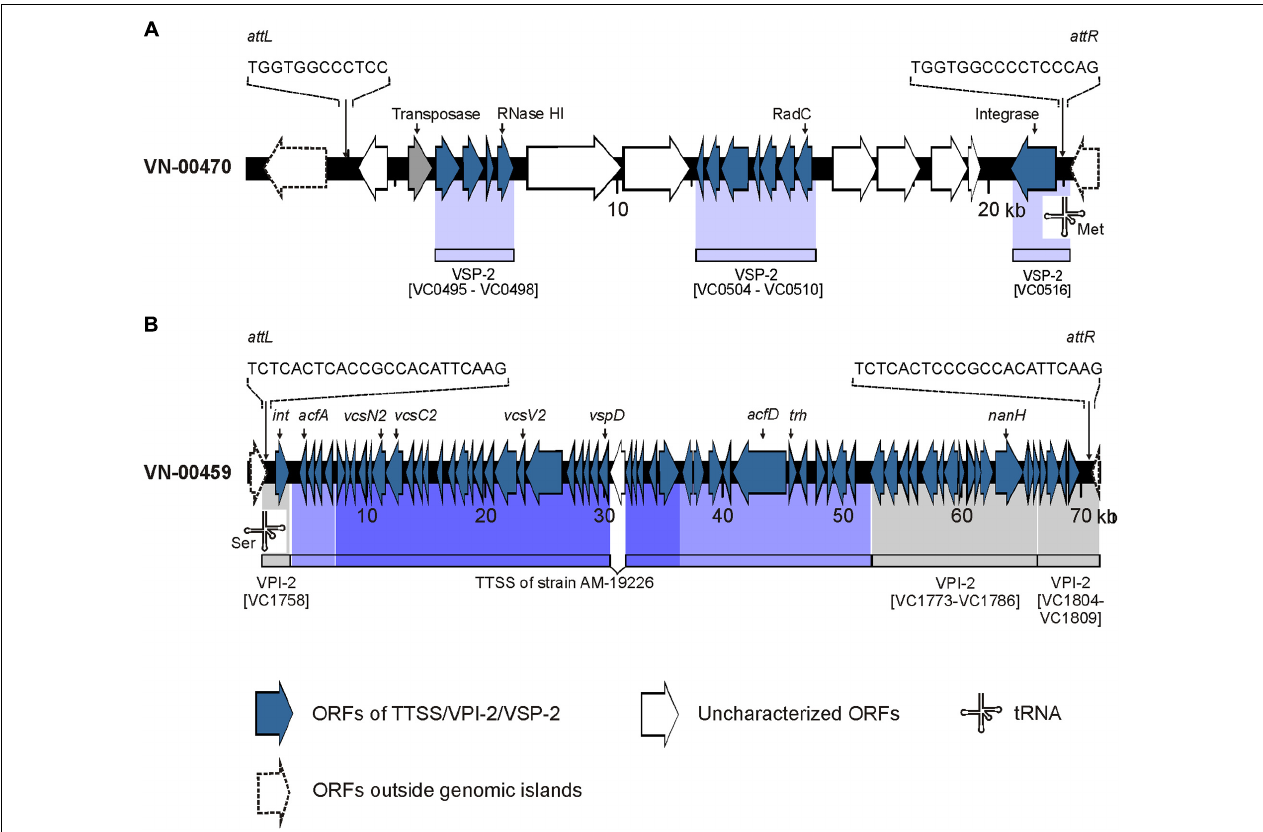
FIGURE 2 | Schematics of genomic islands of the Vibrio cholerae non-O1, non-O139 strains VN-00470 and VN-00459 from the German Baltic Sea. (A) Vibrio seventh pandemic island 2 (VSP-2)-like element identified in strain VN-00470. Light blue areas below the VN-00470 sequence indicate similarity to genes of VSP-2 of V. cholerae O1 reference strain N16961 (gene numbering according to NC_002505.1). (B) Variant Vibrio pathogenicity island 2 (VPI-2) present in strain VN-00459. Gray areas below the VN-00459 sequence indicate similarity to genes of VPI-2 of V. cholerae O1 reference strain N16961 (gene numbering according to NC_002505.1). Blue colored areas below the VN-00459 sequence indicate similarity to the type three secretion system (TTSS) of strain AM-19226 (accession number AATY02000000). Dark blue regions represent the core region of the TTSS. Light blue regions represent the 5 (cid:48) - and 3 (cid:48) -flanking regions of the TTSS. attL , left attachment site; attR , right attachment site; ORF, open reading